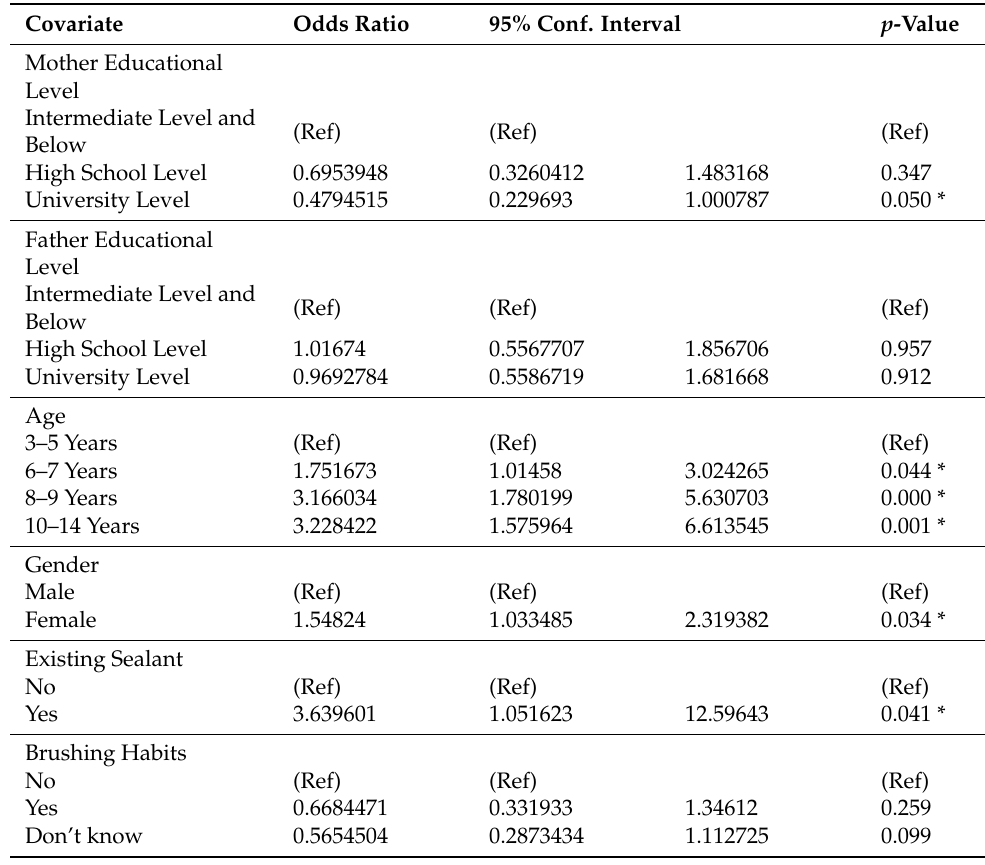
Table 3. Multivariate regression analyses for caries odds ratio adjusted for multiple